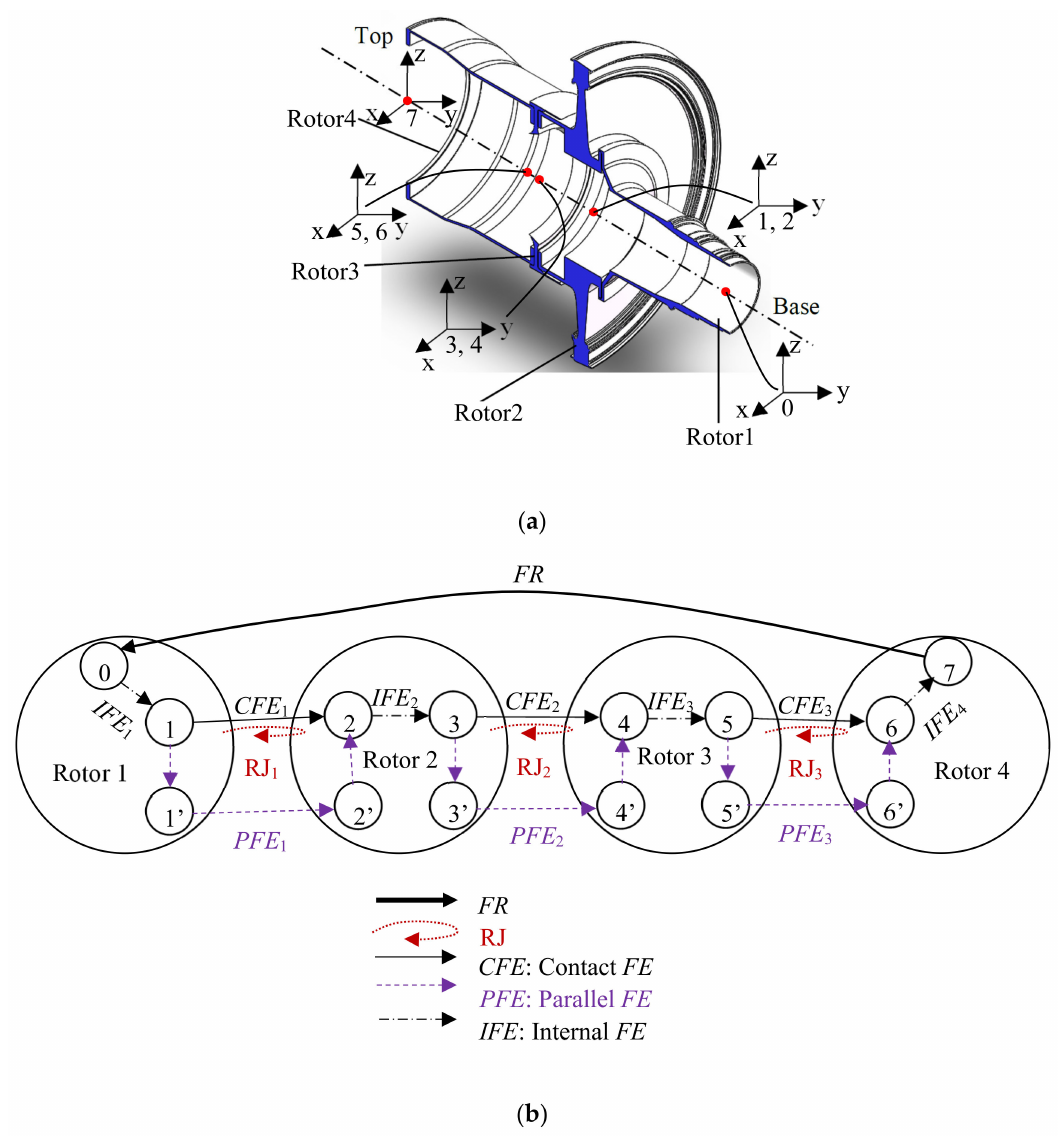
Figure 9. High-pressure turbine rotor assembly: ( a ) Parts drawing; ( b ) Connection